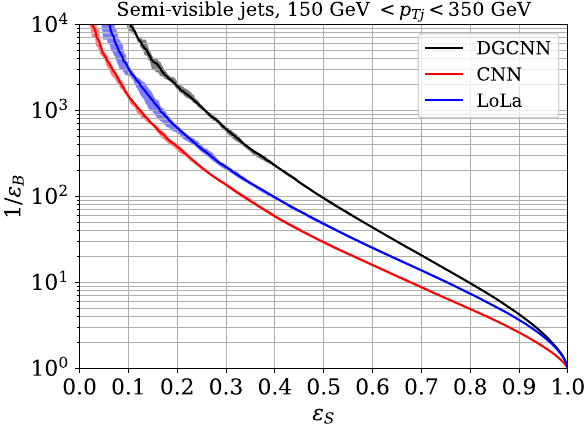
sample containing a number of different dark meson masses m D (here called m meson ) and tested on dark showers with m D as stated in the leg- end (dashed lines), compared to a DGCNN trained and tested on dark showers with identical m D (solid lines). Figures taken from Ref. [73]